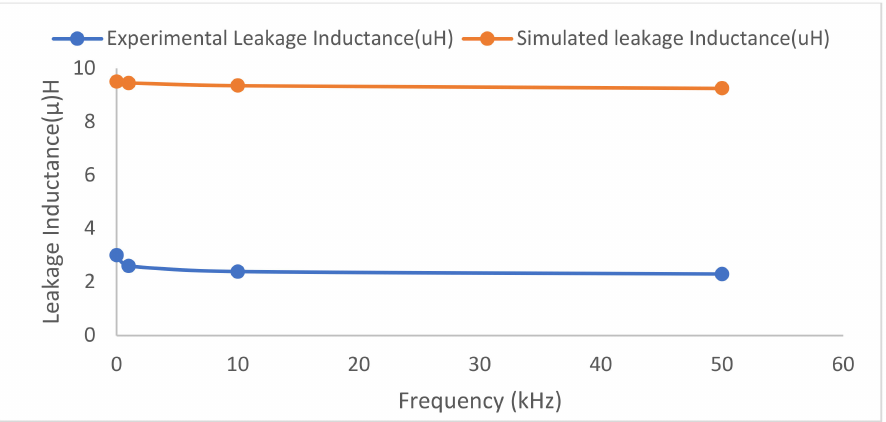
Figure 25. Experimental and simulated comparison of Leakage